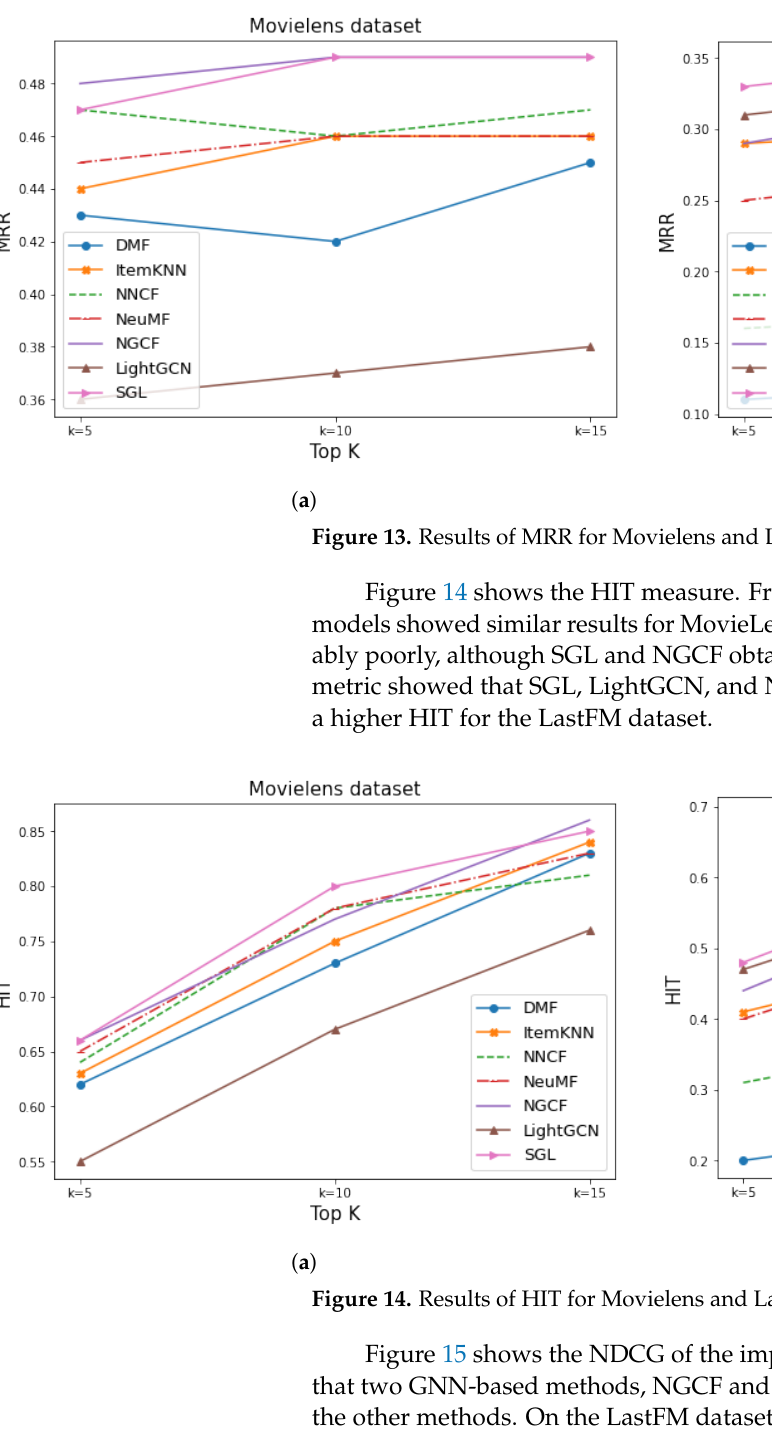
that two GNN-based methods, NGCF and SGL, provided better results for Movielens than the other methods. On the LastFM dataset, the three GNN-based algorithms gave the best values of NDCG, although LightGCN performed better than